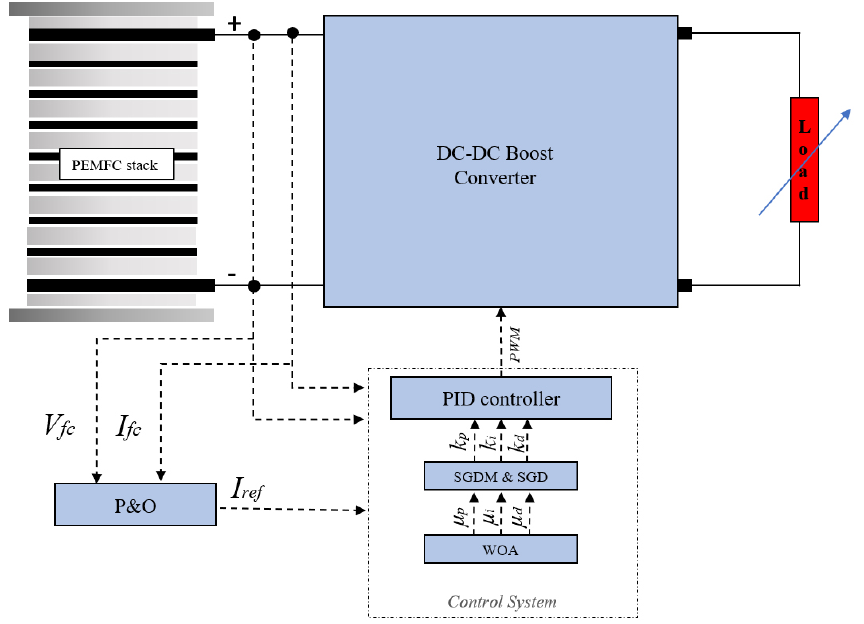
Figure 5. Closed loop